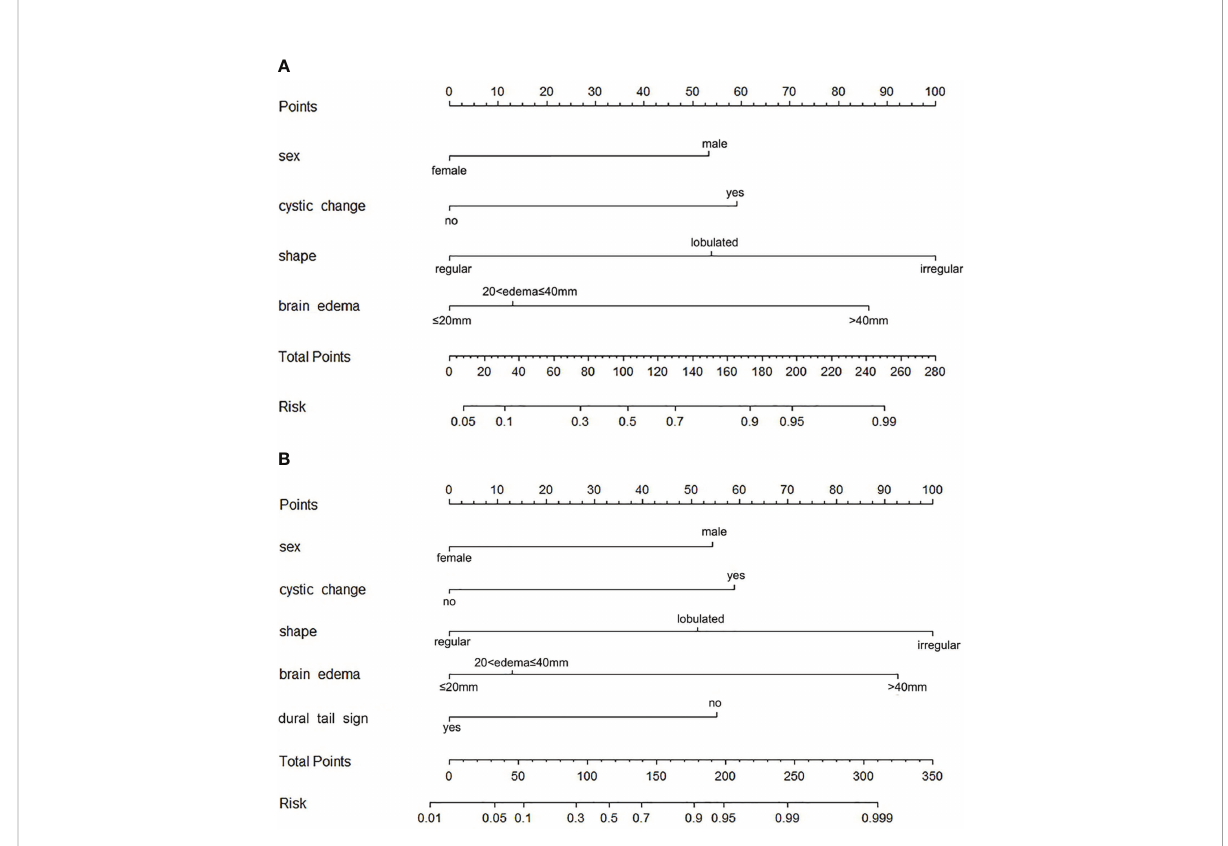
FIGURE 2 Nomograms for identifying high-grade meningiomas. (A) The precontrast – postcontrast nomogram was developed incorporating sex, intratumoral cystic changes, shape, brain edema, and dural tail sign. (B) The precontrast nomogram was developed incorporating sex and precontrast radiological features, including intratumoral cystic changes, shape, and brain